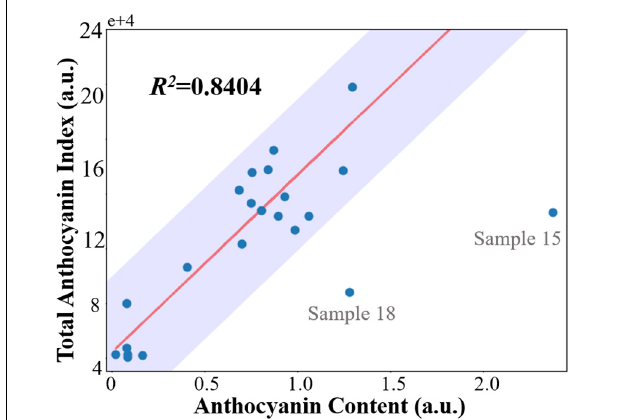
FIGURE 5 | Correlation between the sum of pixel-wise anthocyanin index measured non-invasively by developed fluorescence imager (total anthocyanin index) and total anthocyanin content extracted from whole leaf. The biochemically measured anthocyanin content is expressed in arbitrary units. Data falling in the shaded area [residuals within median absolute deviations (MAD)] are classified as